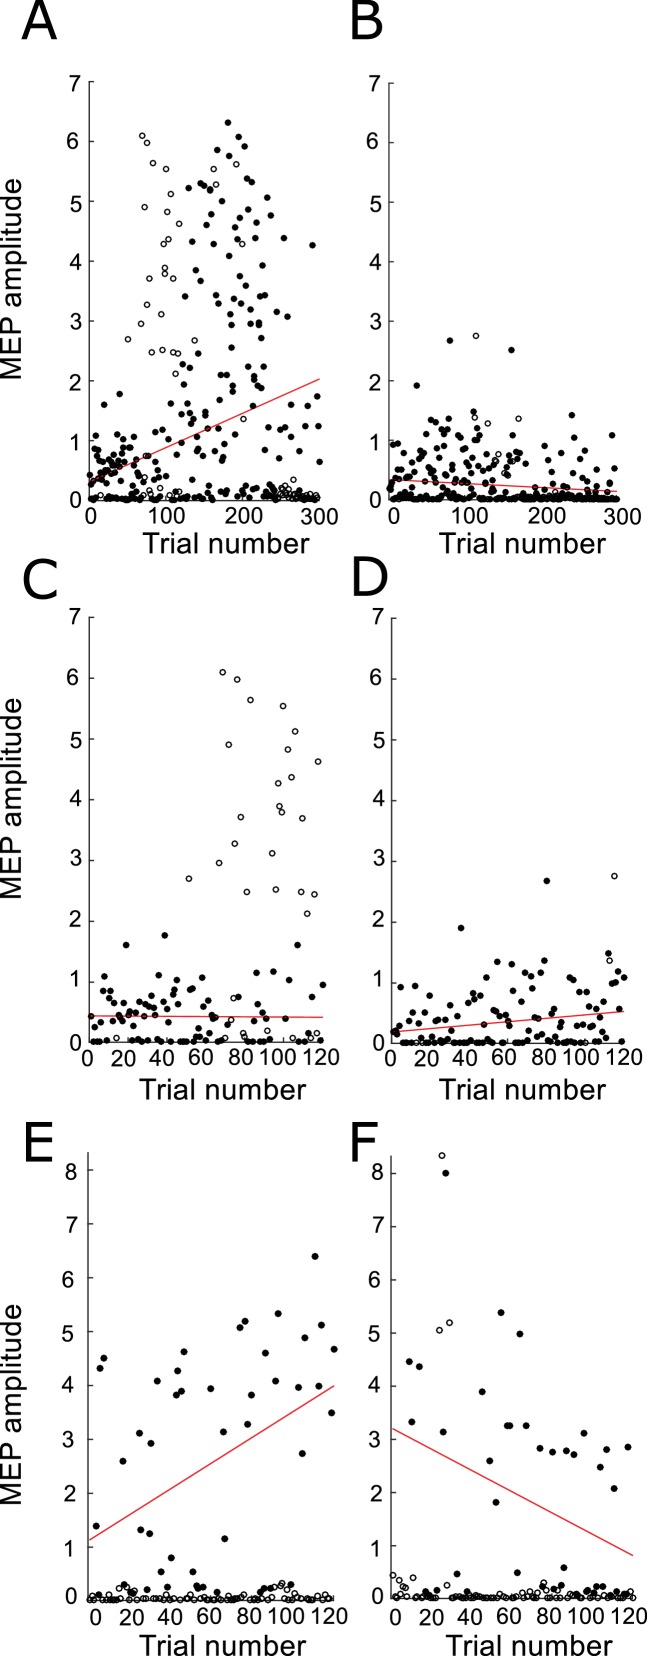
Scatterplots showing individual MEP data trials across learning.Panels (A) and (B) show MEP amplitudes from individual trials from the UP and DOWN conditions respectively, from a representative subject (same as Figure 2—figure supplement 3) in the experimental group. Separate datapoints are shown for MEPs on all 300 neurofeedback trials (across sessions 1–3). Lines of best fit based on robust regression models are plotted in red, indicating a positive slope for the UP training trials (slope = 0.006, p < 0.0001, Rho = 0.373) and a negative slope for the DOWN training trials (−0.0006, p = 0.008, Rho = −0.20). Panels (C) and (D) show the same data but only for the first 120 trials of UP and DOWN MEPs (Session 1), from the same subject shown in panels A and B. This is an example of a slow learning subject, who did not exhibit significant trial-related changes in MEP amplitude in the expected direction during the first session of training. Panels (E) and (F) show the same data but from a subject who exhibited faster learning of the task. In this case within the first 120 trials there was a positive slope for UP training (slope = 0.023, p = 0.006, Rho = 0.385) and negative for DOWN training (slope = −0.019, p = 0.021, Rho = −0.399), indicating that their MEP amplitudes were increasing (or decreasing) as trial number incremented. In each the scatterplots shown, all 300 (or 120) MEP amplitudes are plotted as individual dots, with those excluded from analyses due to background EMG indicated as unfilled data points. These are shown in the interests of transparency, but have not been included in any statistical analyses or lines of best fit.